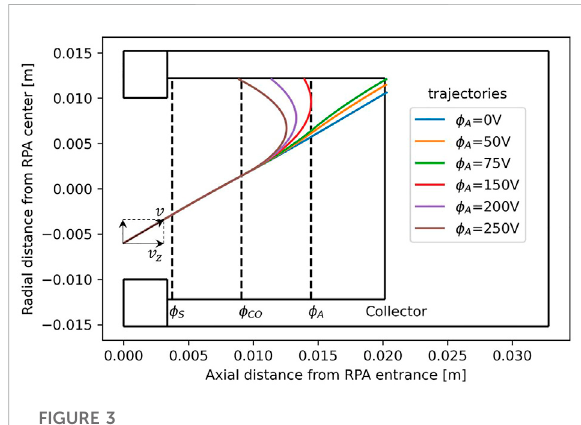
FIGURE 3 Trajectories of an ion Xe + (total energy of 250 eV and a tilt- angle β RPA (cid:2) 40 ° ) in Express-A RPA for different values of analyzer grid potential. The grid potentials are ϕ S (cid:2) 0V and ϕ CO (cid:2) − 30V , and ϕ A varies between 0 and 250